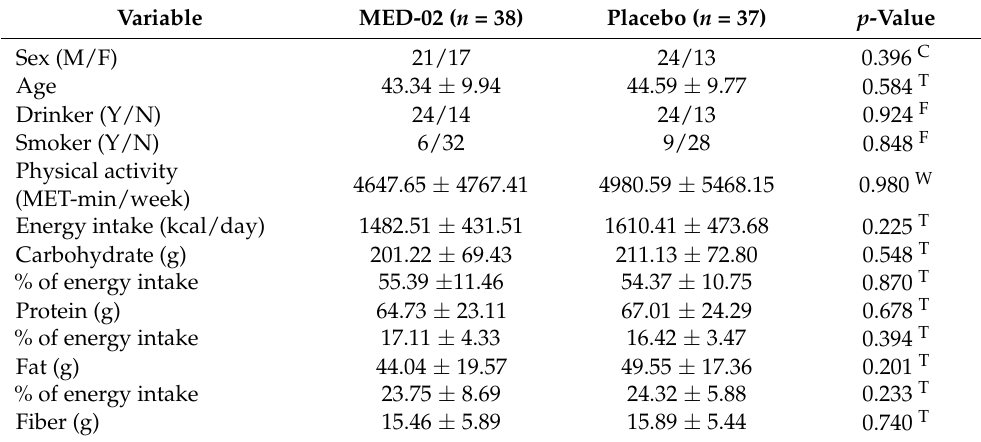
Figure 1. Flow diagram of the enrolled participants. Table 1. Baseline demographic characteristics of the subjects.